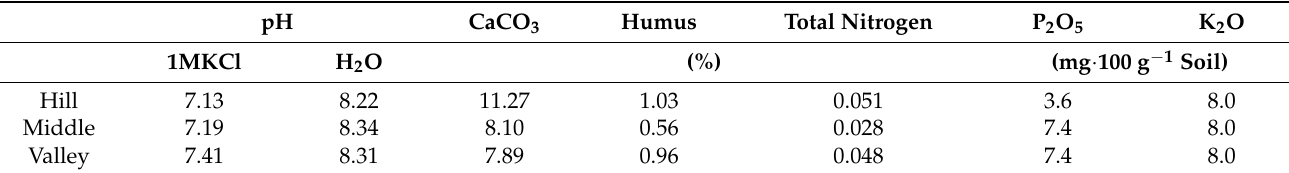
Table 1. Basic chemical characteristics of the soil.